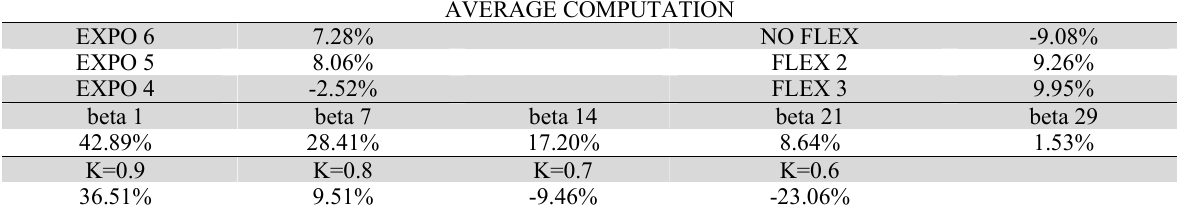
Simulation results WIP